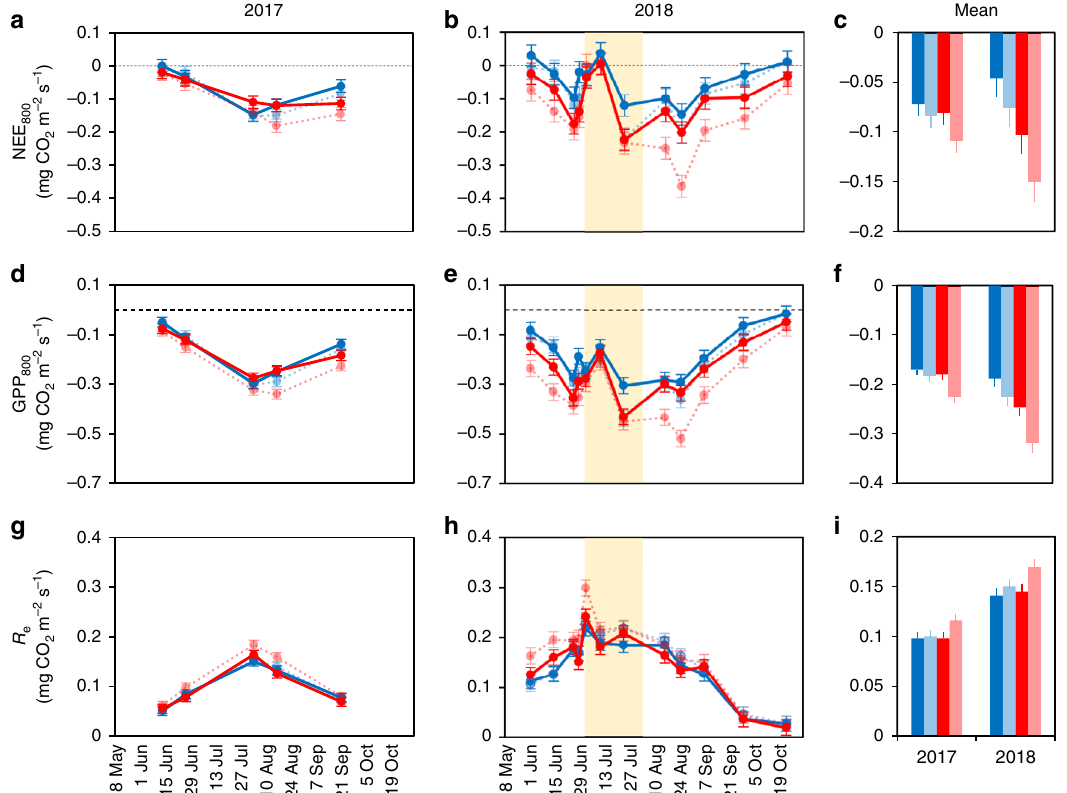
Fig. 1 Warming and reduction in herbivory increase GPP and ecosystem CO 2 uptake potential. Left hand and middle panels show the variation in daytime CO 2 fl uxes: a , b net ecosystem exchange NEE 800 , d , e gross primary production GPP 800 , and g , h ecosystem respiration R e in warmed (red) and ambient (blue) fi eld plots of Subarctic mountain birch forest fi eld layer vegetation (supplemented with cloned birch plantlets) during growing seasons 2017 and 2018 (dots are estimated marginal means ± s.e.m. produced by the fi tted statistical model in Table 2; n = 5 fi eld plots). Right hand panels show seasonal means ± s.e.m. of c NEE 800 , f GPP 800 , and i R e (means are estimated marginal means produced by the fi tted statistical model in Table 2, n = 5 fi eld plots examined over 5 [year 2017] or 12 [year 2018] repeated measures). Light tone dashed lines, symbols, and bars denote plots, where herbivory was reduced using an insecticide. The pale yellow background stripe stands for the period of severe hydrological stress (2nd July – 1st August, 2018; see Fig. 3). Source data are provided as a Source Data fi